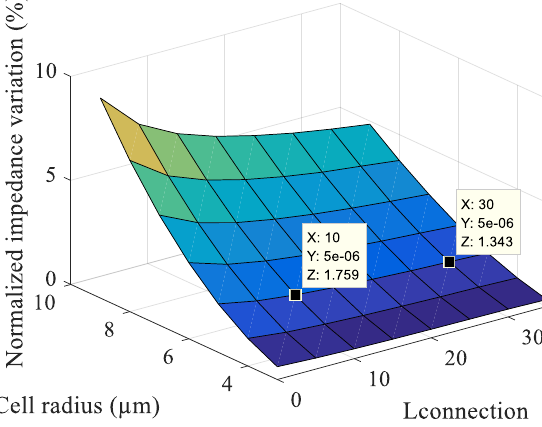
Figure 8. Normalized impedance variation as a function of the volume ratio and connection length.